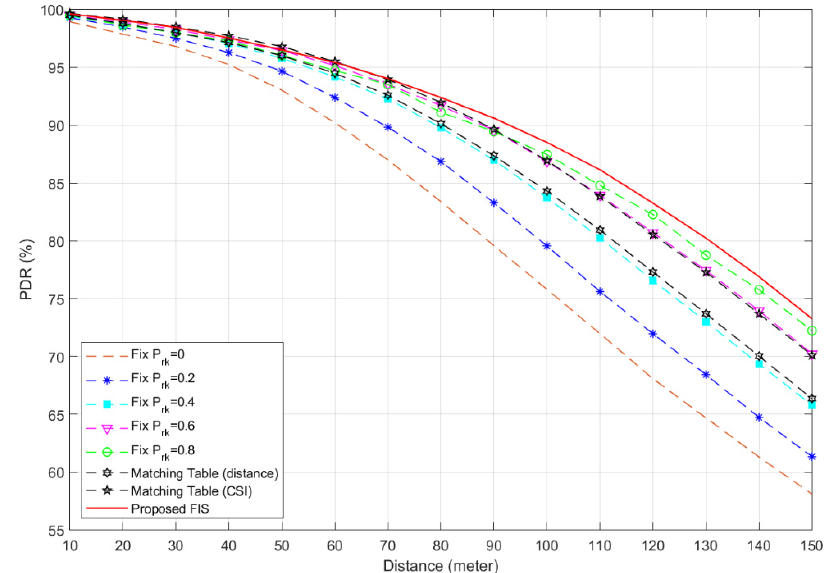
Figure 10. Overall PDR performance comparison for n V = 400 vehicle scenario.